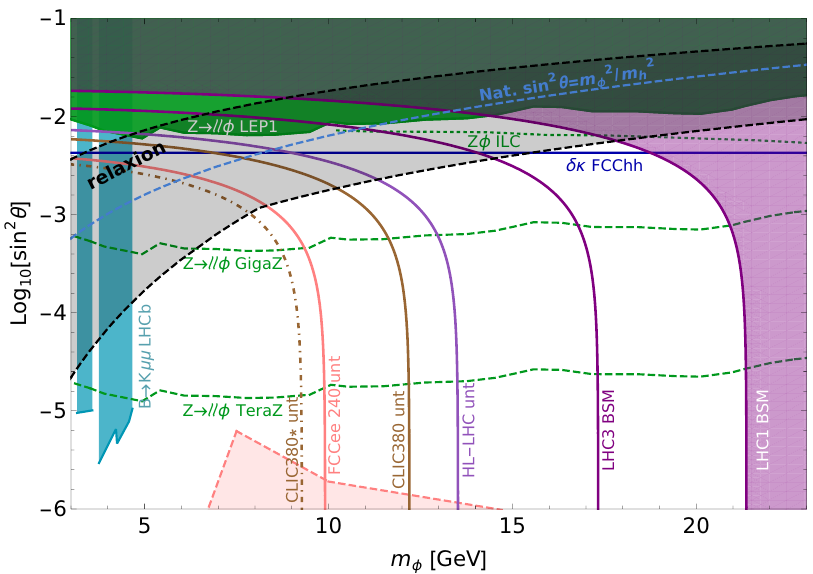
Figure 10 . Prompt bounds on sin 2 θ and m φ for the relaxion, arising from direct and indirect probes at various hadron and lepton colliders, as in figure 9. The dash-dotted line stems from the one-parameter fit for CLIC as detailed in section 3.1. The gray band marks the region where the relaxion can be natural, see section 2.2. The upper bound is given by eq. (2.38) for the relaxion stopping in the first minimum ( n = 1 ). The lower bound for low m is dominated by the stopping φ in a generic minimum ( n (cid:29) 1 ), see eq. (2.42); for high m by the solution for n = 1 , see eq. (2.39). φ The bands corresponds to a choice of Λ = ˜ M = 1 min max